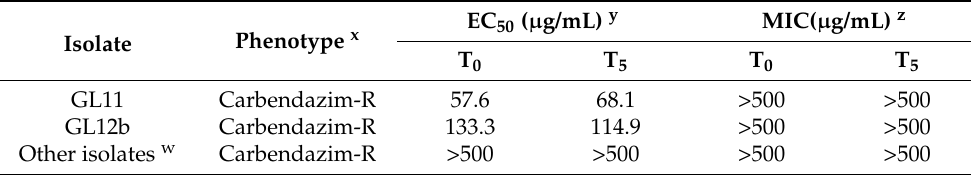
Table 2. Stability of resistant Ustilaginoidea virens isolates to carbendazim.